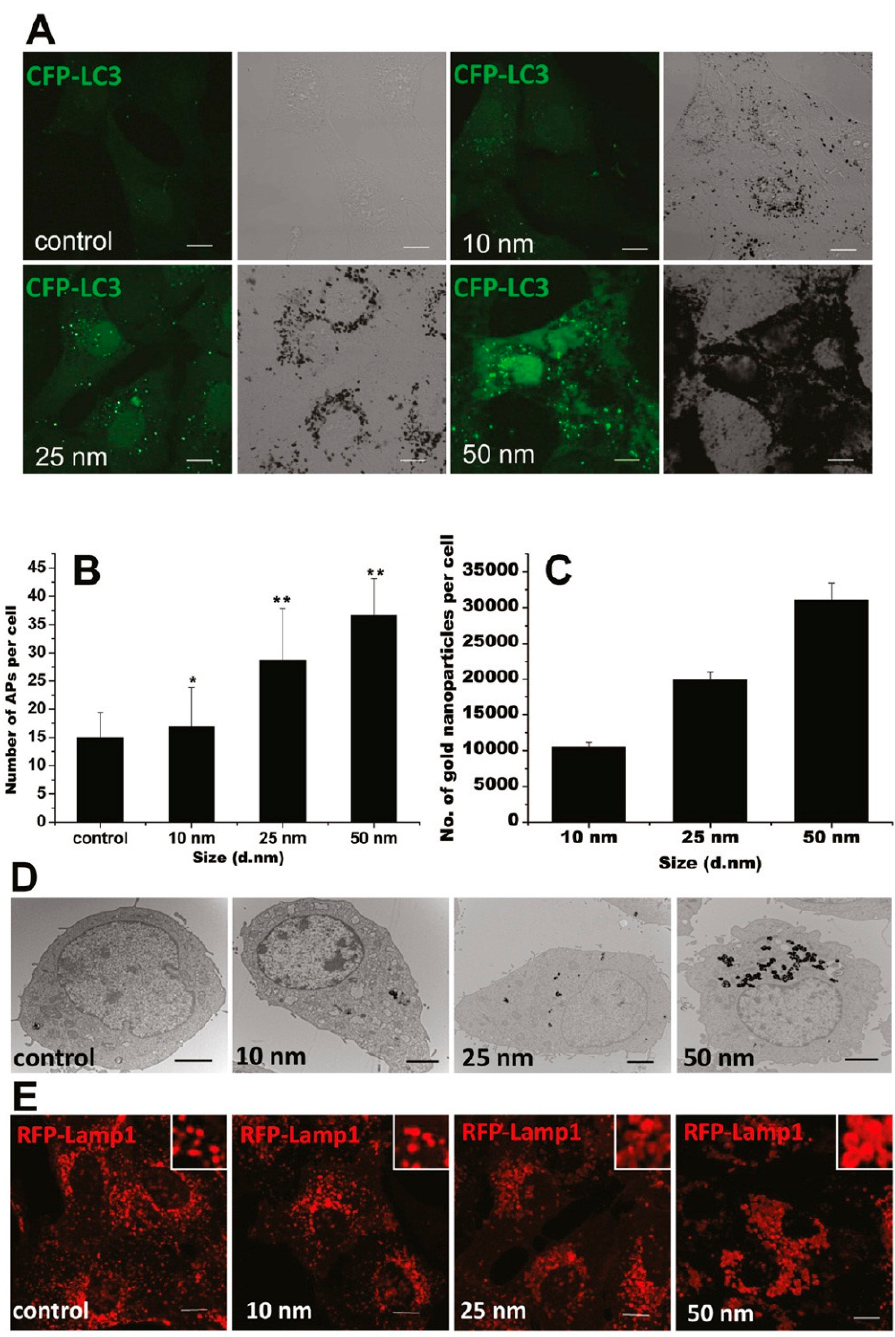
Figure 3. GNPs induce autophagosome accumulation through size-dependent nanoparticle uptake and lysosome impairment. ( A ) Formation of cyan fluorescent protein (CFP)-LC3 dots (pseudocolored as green) in CFP-LC3 NRK cells treated for 24 h with 1 nM GNPs of the sizes indicated. Left, confocal image; right, bright-field image (scale bar, 10 μ m). ( B ) Statistical analysis of the number of autophagosomes (APs) per cell after 24 h of treatment. ( C ) Size-dependent cellular uptake of GNPs. The graph shows the number of GNPs per cell after incubation with 1 nM GNPs for 24 h. ( D ) TEM images of NRK cells untreated (control) or treated with GNPs with diameters of 10, 25, and 50 nm. The GNPs are internalized by cells and trapped inside lysosomes (scale bar, 2 µ m). ( E ) Vacuoles induced by GNP treatment are enlarged lysosomes. NRK cells were incubated for 24 h with plain medium (control) or with 1 nM GNPs. Inset: close-up of the enlarged lysosomes (scale bar, 10 µ m). Adapted with permission from reference [103]. Copyright (2011) American Chemical